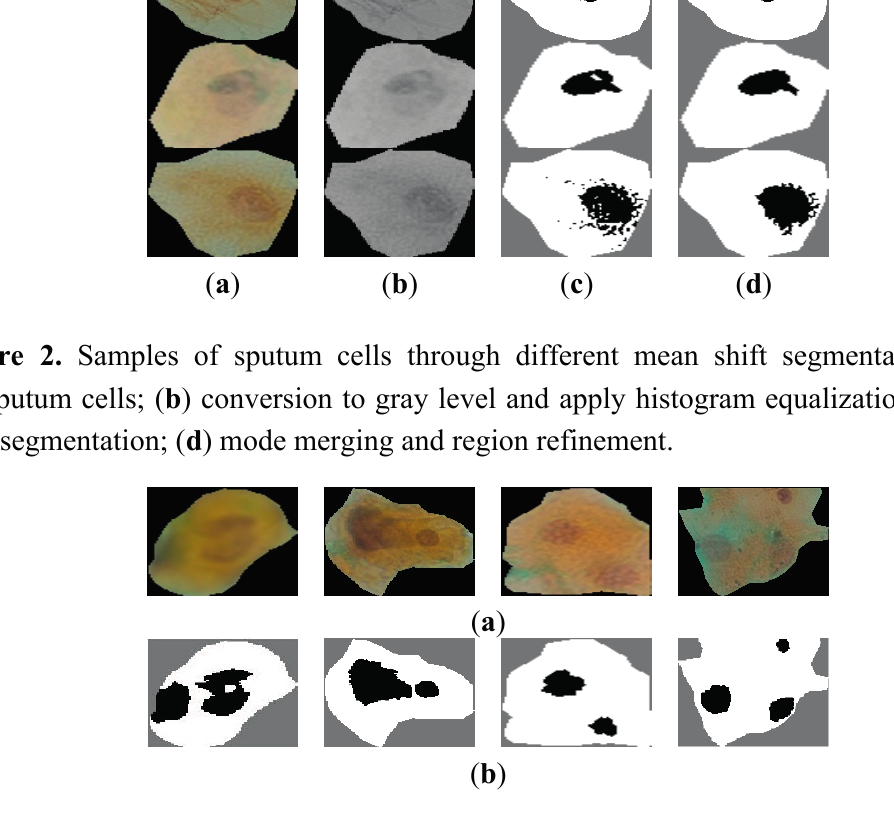
Figure 3. Mitosis (cell division). ( a ) raw cells and ( b ) two or more nuclei in each